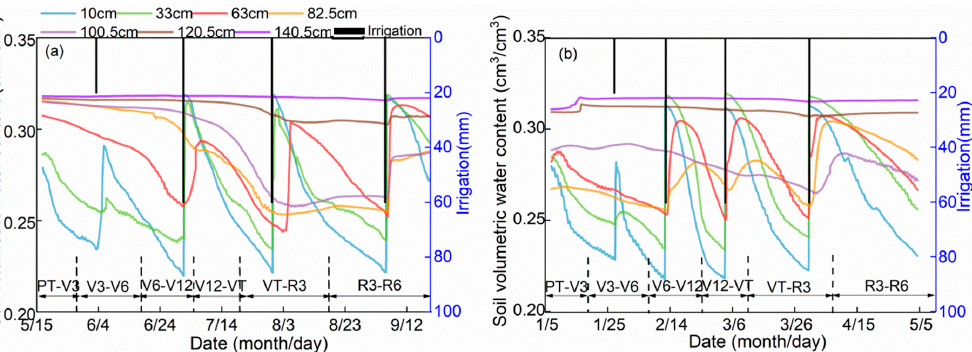
Figure 3. Half-hourly variations in soil volumetric water content (VWC) at different depths in ( a ) T-control and ( b ) T-warm experiments, respectively.